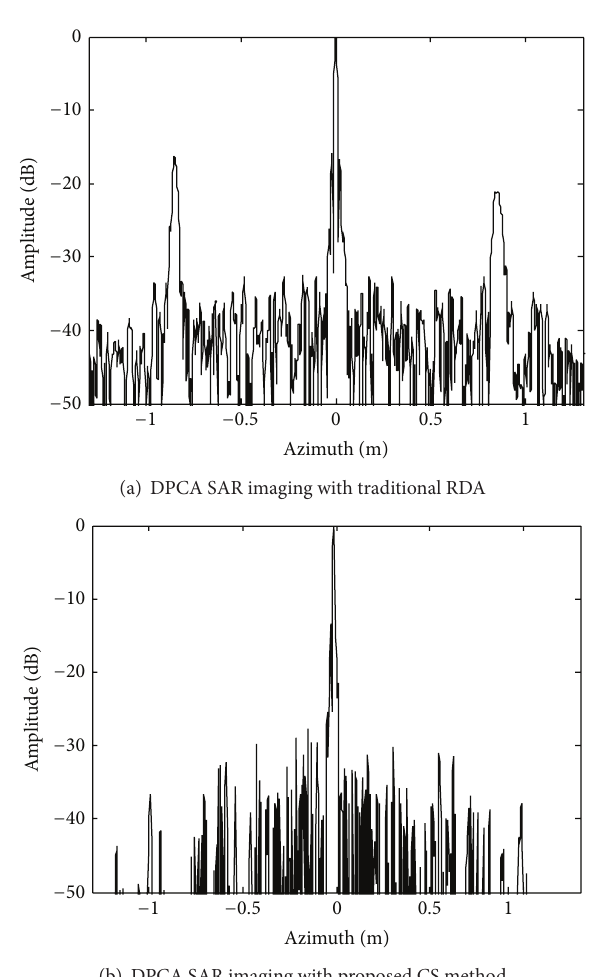
Figure 13: Experimental results of azimuth